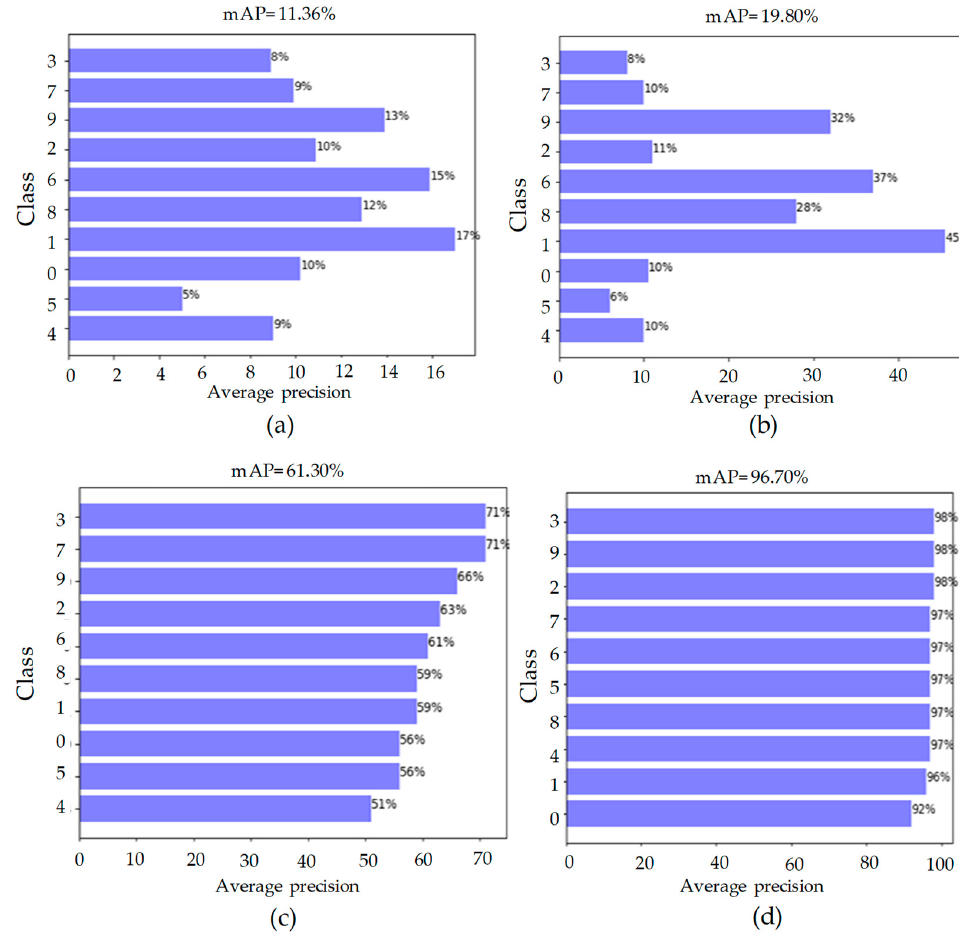
Figure 18. mAP comparison results for only numbers (0–9). ( a – d ) represent the mAP results on bicubic results ( × 4), DBPN results ( × 4), proposed SR results ( × 4), and HR images, respectively. Table 4. Average mAP (%) comparison of LR license plates for validation of 122 classes (0–121). Scale